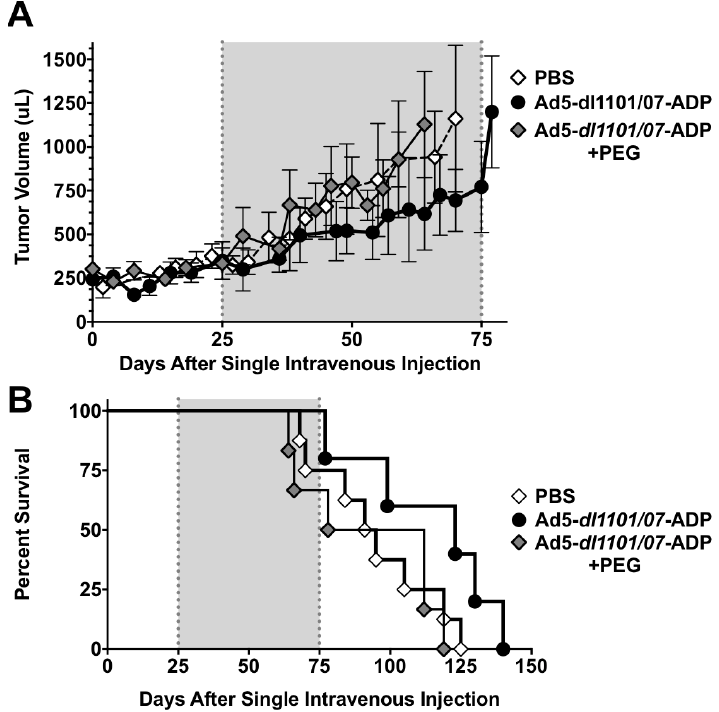
Figure 7. Efficacy of unmodified and PEGylated Ad5- dl 1101/07 in immunocompetent hamsters. Hamsters with established HaK tumors were injected i.v. by the jugular route with a single dose 3 × 10 10 vp of Ad5- dl 1101/07 or Ad5- dl 1101/07 5 kDa PEG. ( A ) Tumor volumes ( n = 5 to 8 per group) were measured twice a week and the mean values were calculated from tumor dimensions and all individual tumor size; ( B ) Loss of survival as described in Figure